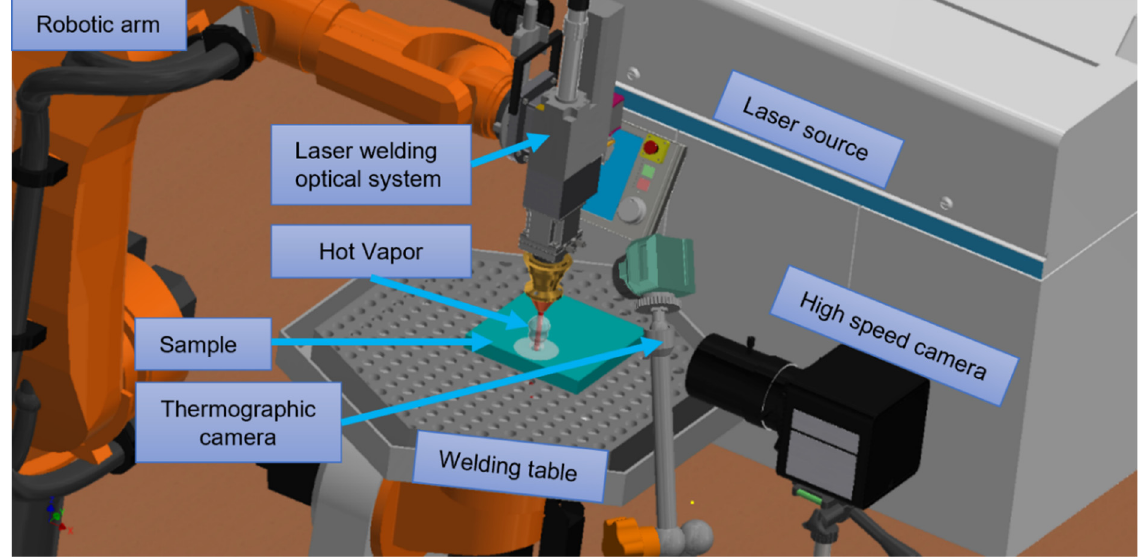
Figure 1. Schematic of experimental set-up for laser welding monitored by a high-speed imaging camera.